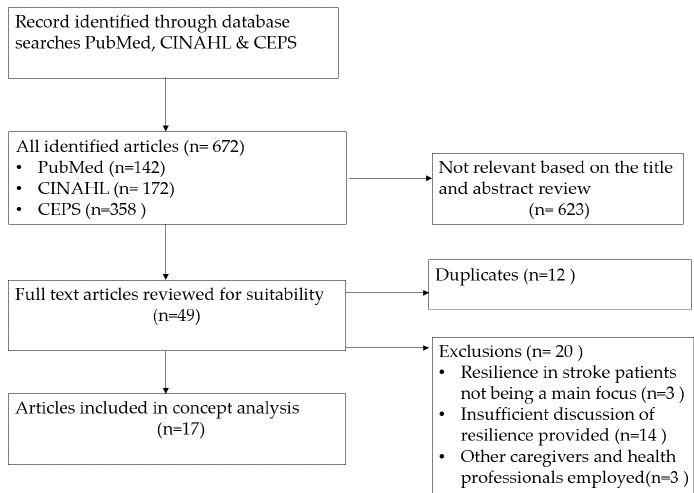
Figure 2. Flow chart of literature search.